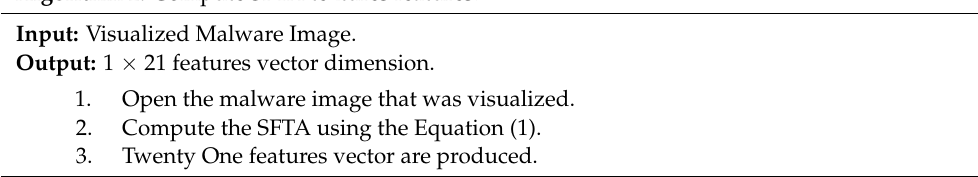
Algorithm 2: Compute SFTA textures features.